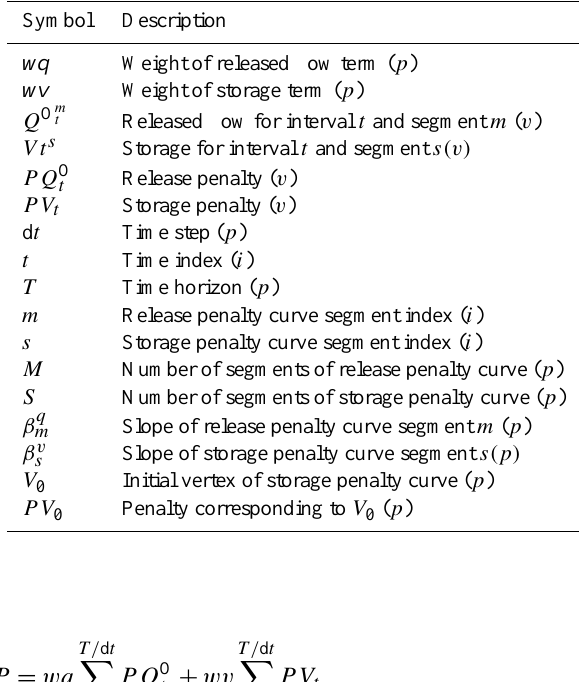
Table A1. Meaning of the variables ( v ), indices ( i ) and parameters ( p ) of the